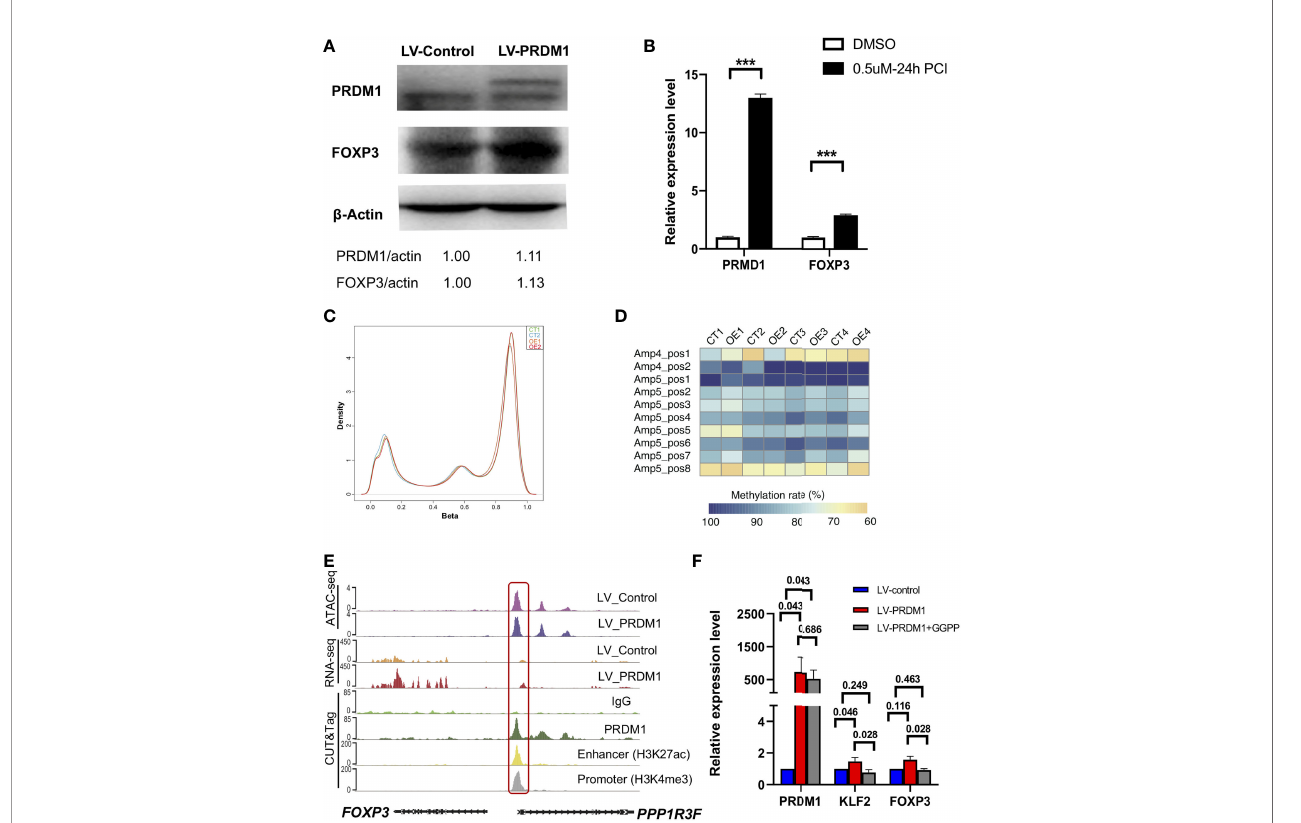
FIGURE 5 | PRDM1 induced FOXP3 expression by directly binding to upstream enhancer and indirectly by upregulating KLF2. (A) Western blot showed the protein level of PRDM1 and FOXP3 in PRDM1 overexpressing Jurkat T cells compared with control T cells (two experiment repeats). (B) Quantitative real-time PCR showed the expression level of PRDM1 and FOXP3 in Jurkat cells treated with DMSO or PCI-24781. (C) Density of beta values distribution in PRDM1 -overexpressing T cells and control T cells. (D) Heatmap showed the degree of methylation at each CpG motif according to the color code. (E) WashU browser views showed PRDM1 biding sites and histone modi fi cations around FOXP3 gene locus. (F) Quantitative real-time PCR showed the expression level of PRDM1 , KLF2 and FOXP3 in control T cells, PRDM1 -overexpressing T cells and KLF2 inhibitor GGPP treated PRDM1 -overexpressing T cells, respectively (n = 6). Friedman Test showed the P value is 0.03 for PRDM1 , KLF2 and FOXP3 . Then P value was analyzed by Wilcoxon rank sum test. ***P <